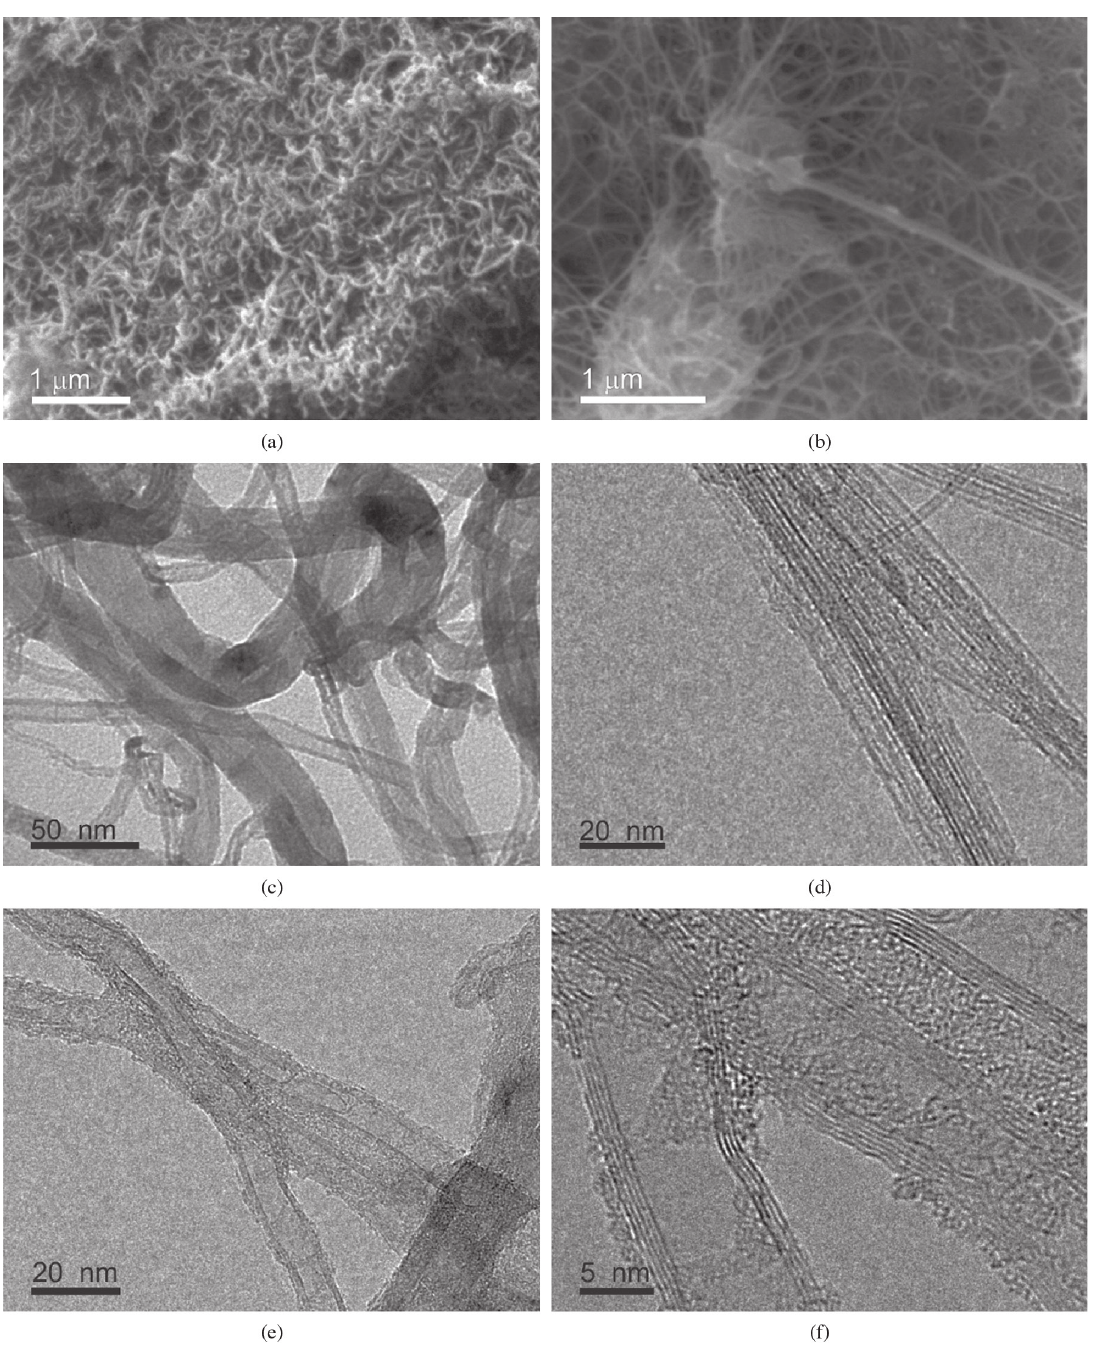
Figure 1. SEM (a, b) and TEM (c, d, e, f) of nanoadsorbents: (a, c) MWCNT; (b, d) SWCNT and (e, f) RB-4 dye adsorbed MWCNTs.